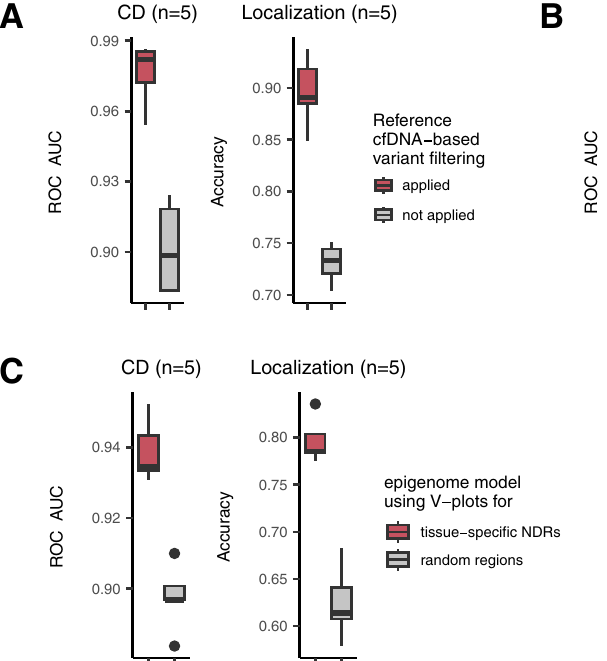
used for the construction of V-plot images for cancer detection (left) and locali- zation (right). The same number of random regions were selected for comparison withtissue-speci fi cNDRs. A – C Five-foldcross-validationwasperformedtoexamine the distribution of ROC-AUC and accuracy values. Each box indicates IQR and median, whiskers indicates 1.5× IQR, black dots indicates outlier. CD cancer detection, Localization cancer localization. Source data are provided as a Source Data fi